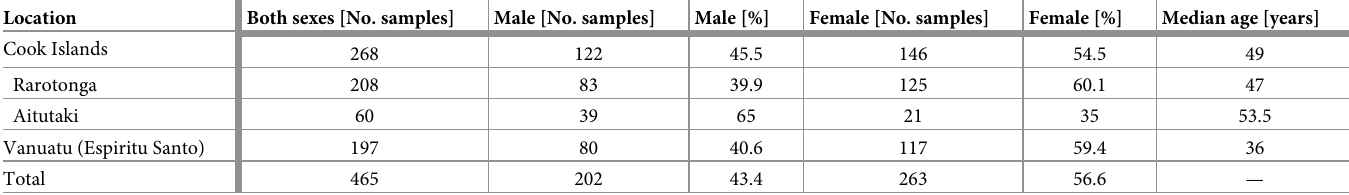
Table 2. Test population structure–gender distribution and median age.